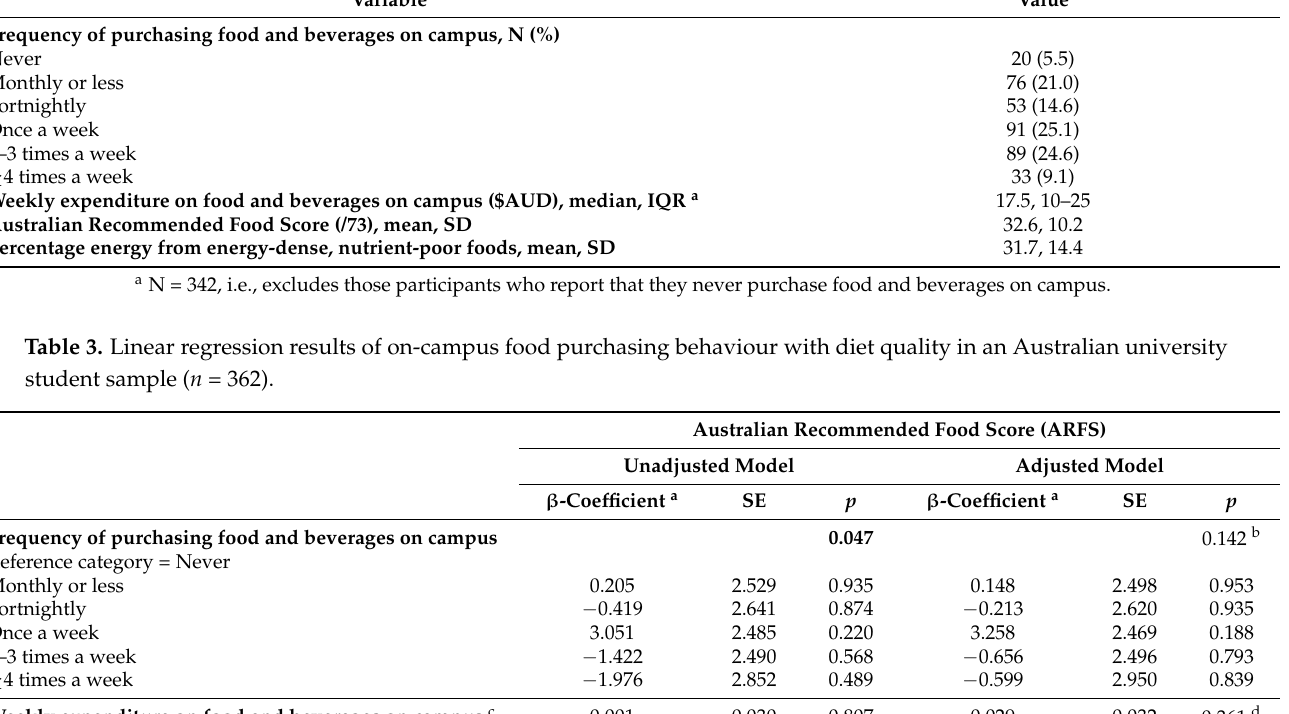
Table 2. On-campus food purchasing behaviour and dietary intake of an Australian university student sample ( n = 362). Variable Value